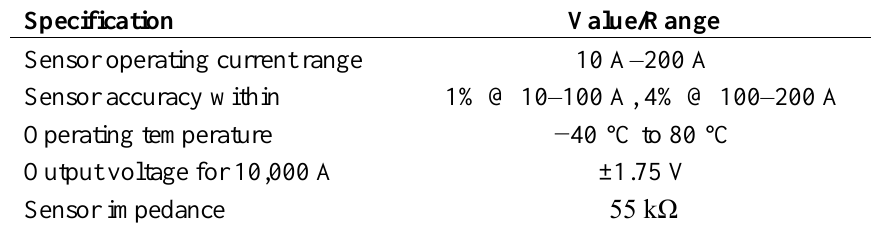
Table 1. Design specifications and constraints considered for the sensor design.